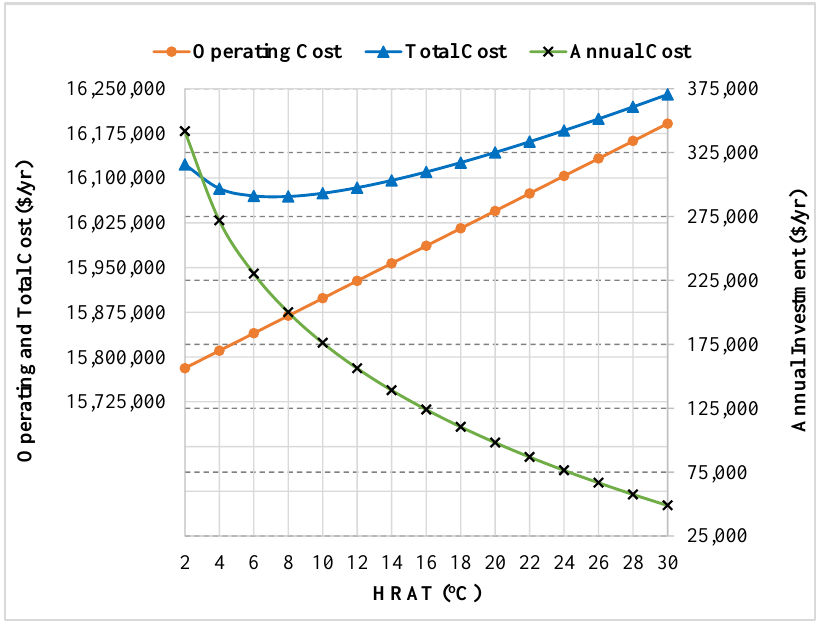
Figure 4. Economic profile of the optimized HEN using option (1).